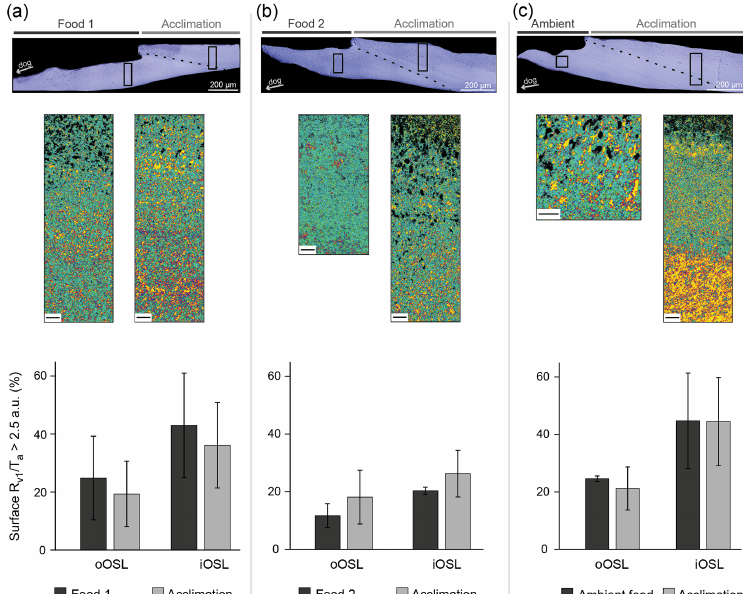
Figure 7. Effect of different diets based on (a) food type 1, (b) food type 2 and (c) ambient food on biomineral orientation. The optical microscope images indicate the position of the Raman scans. Dotted line marks the start of the experiment. The portion of shell prior the line was formed during the acclimation phase; dog is direction of growth. The Raman spectral maps indicate the ratio R ν 1 /T of the scan. For each shell, maps on the left represent shell portions during the experiment, maps on the right represent shell portions formed during the acclimation phase. In the acclimation portion of the sample reared with ambient food, a significant change in the microstructure orientation is visible. The respective area of the Raman map was not considered in further calculations because it was influenced by the emersion and transportation stress at the start of the experiment. Scale bars = 10µm. The graphs show the proportions of biominerals of > 2 . 5a.u. with respect to the total map area. oOSL and iOSL with R ν 1 /T a